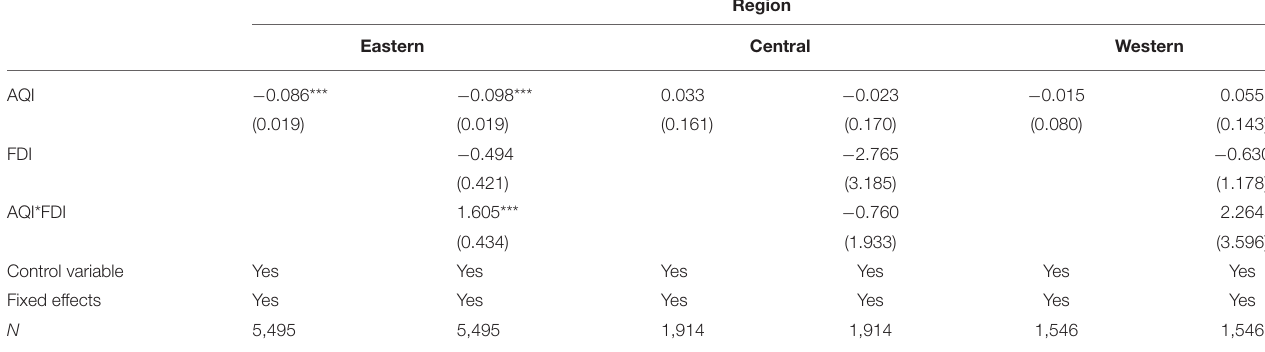
TABLE 6 | Heterogeneity in the eastern, western, and central